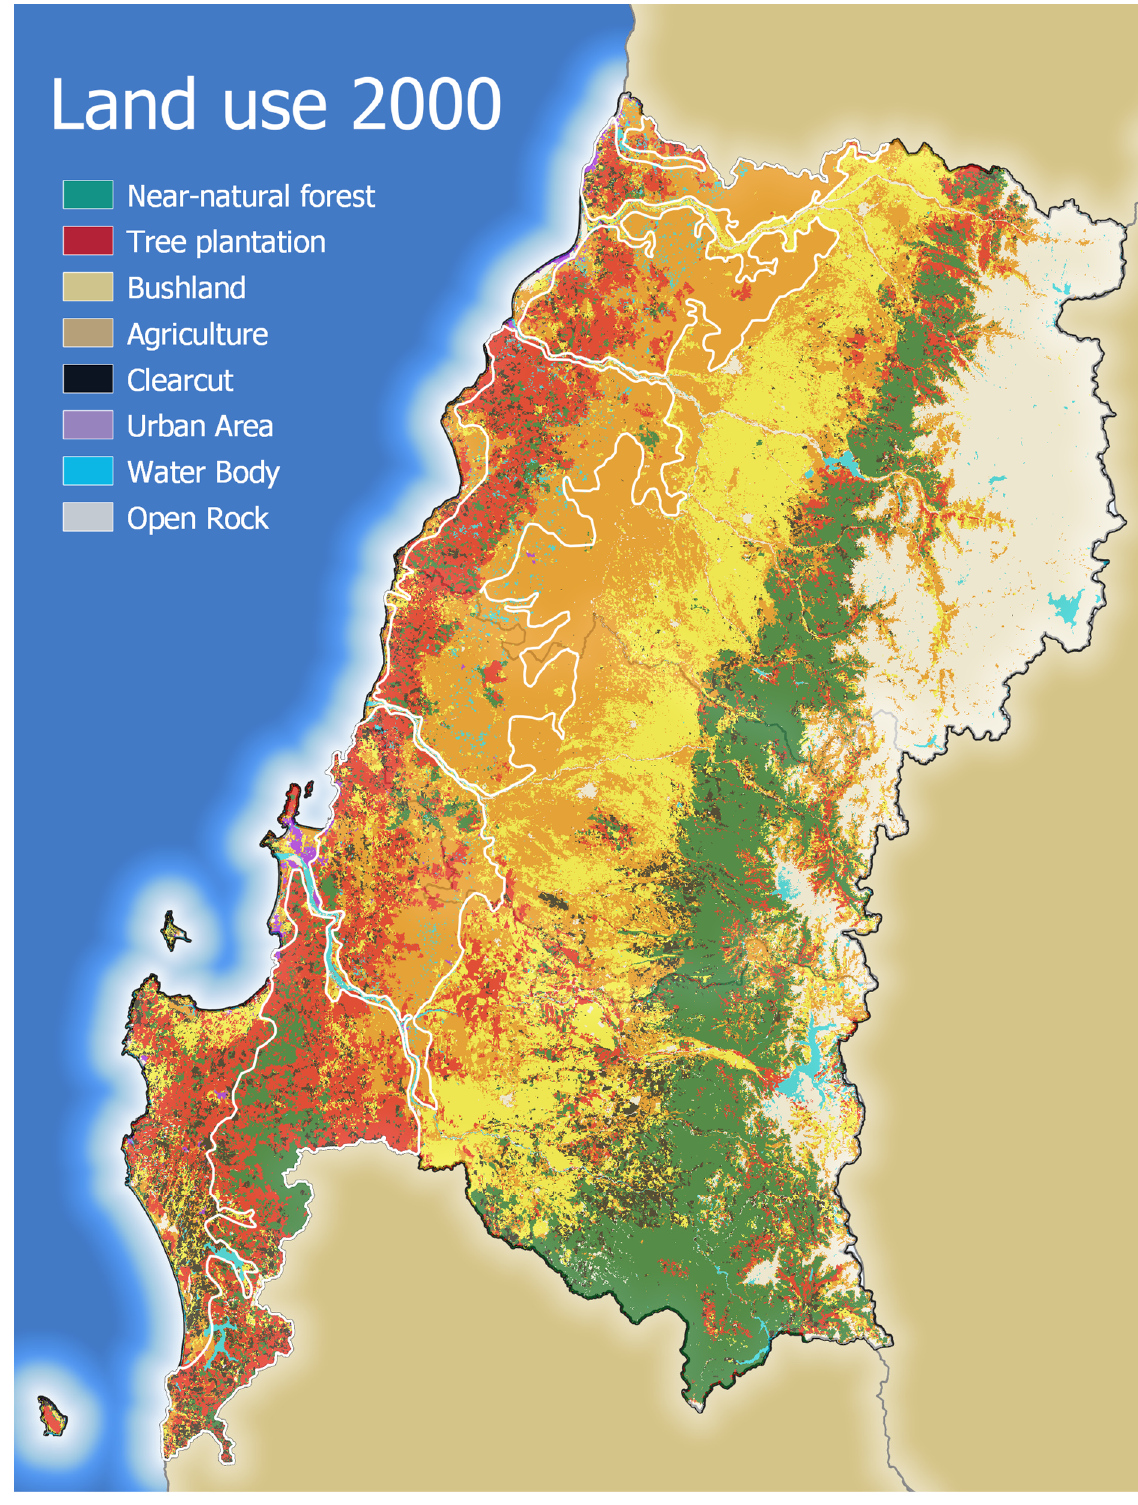
Figure A6. Land use map of study site in 1995.